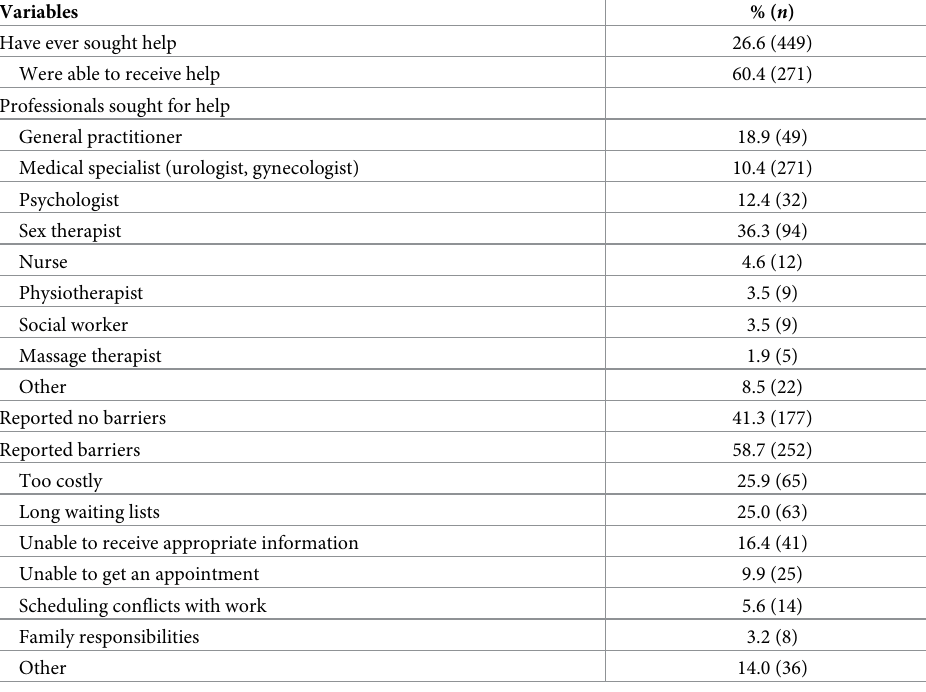
Table 4. Help-seeking behaviors and barriers to services among the community sample ( n =